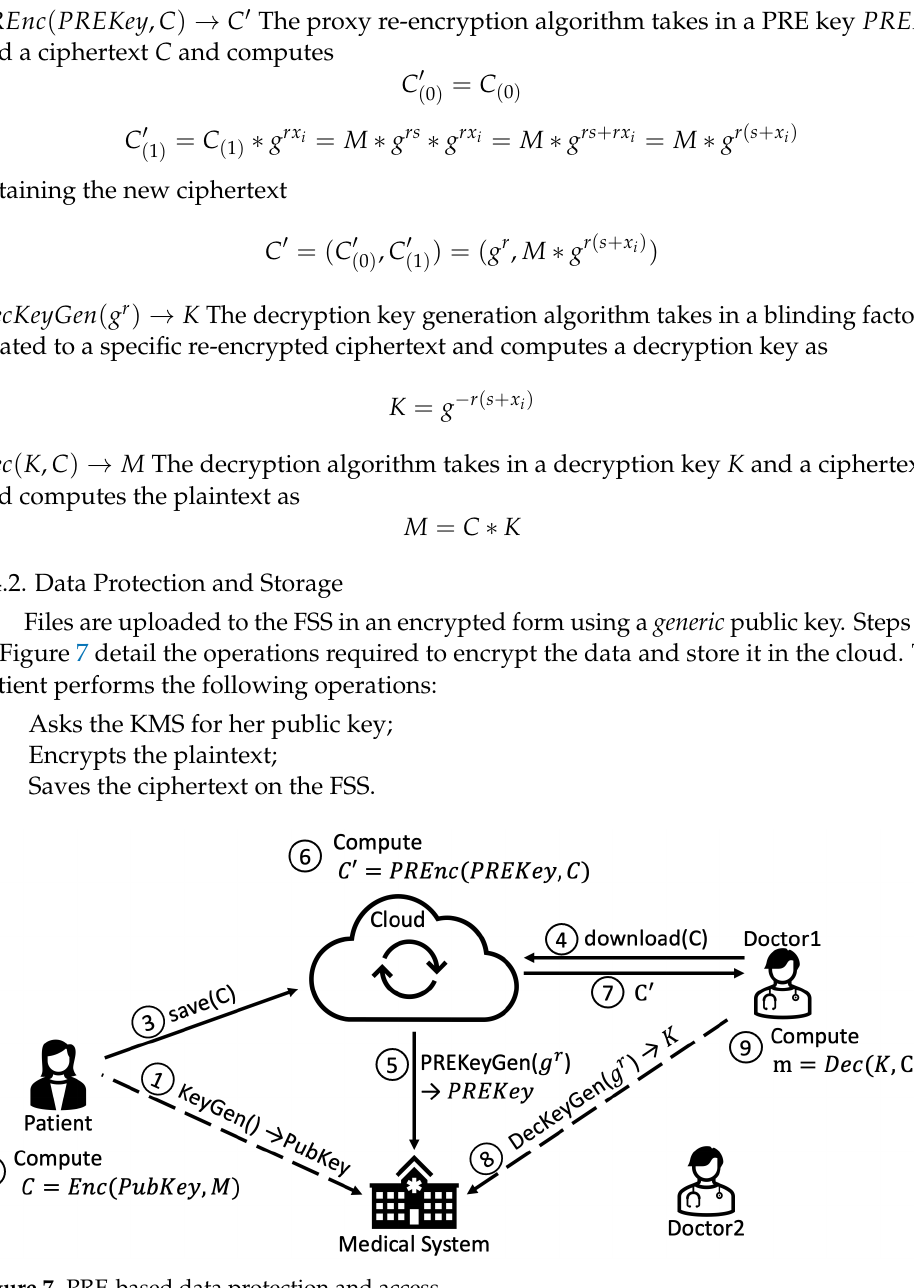
Figure 7. PRE-based data protection and